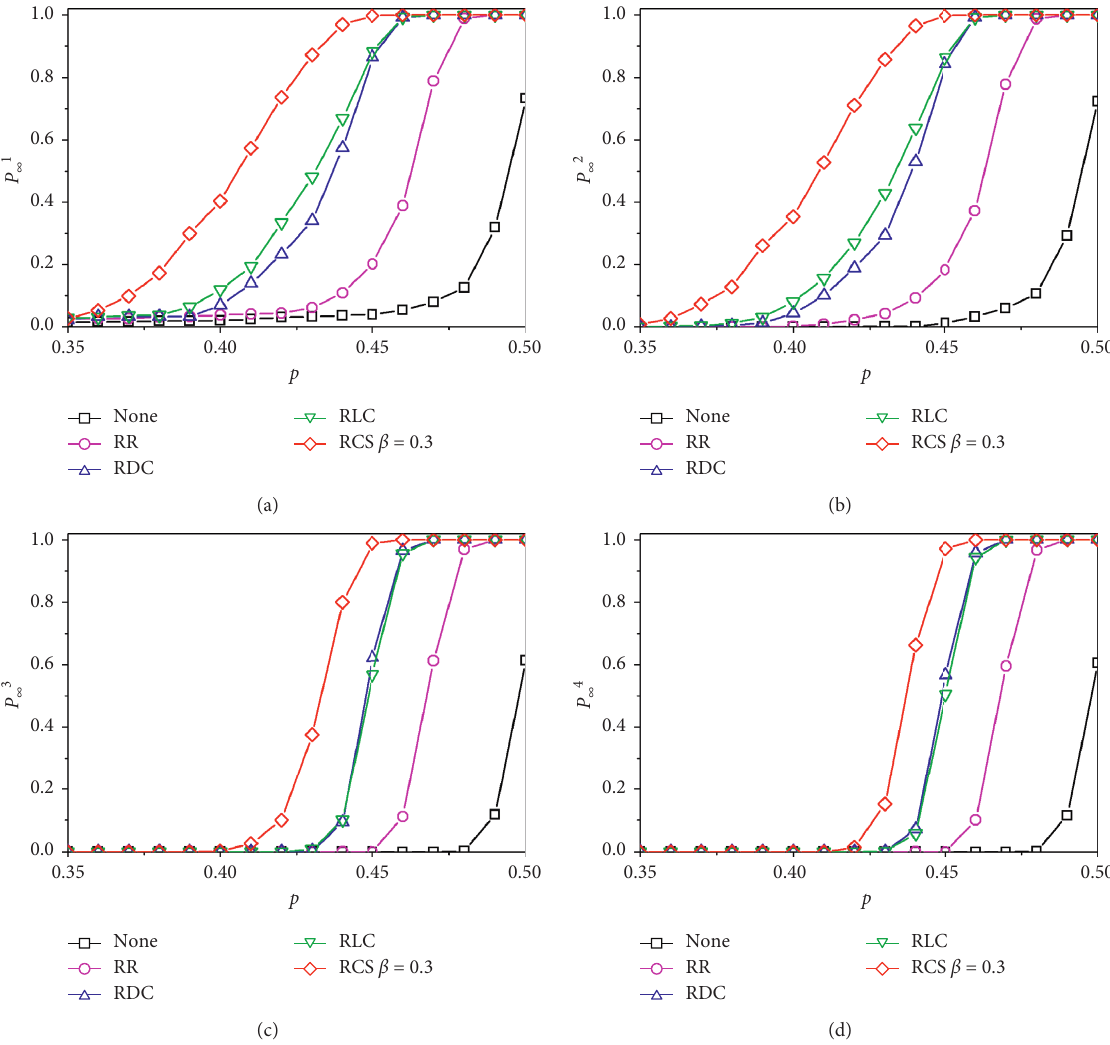
Figure 10: The existence probability of giant component as a function of the fraction of surviving nodes p on the ICNs with ER-ER structures, when noisy input nz � 0.01. (a) P 1